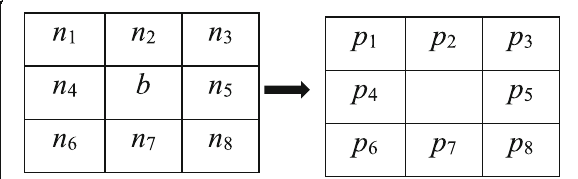
Fig. 2 A block of pixels with center pixel b and neighbors n 1 to n 8 is transformed into a ternary pattern